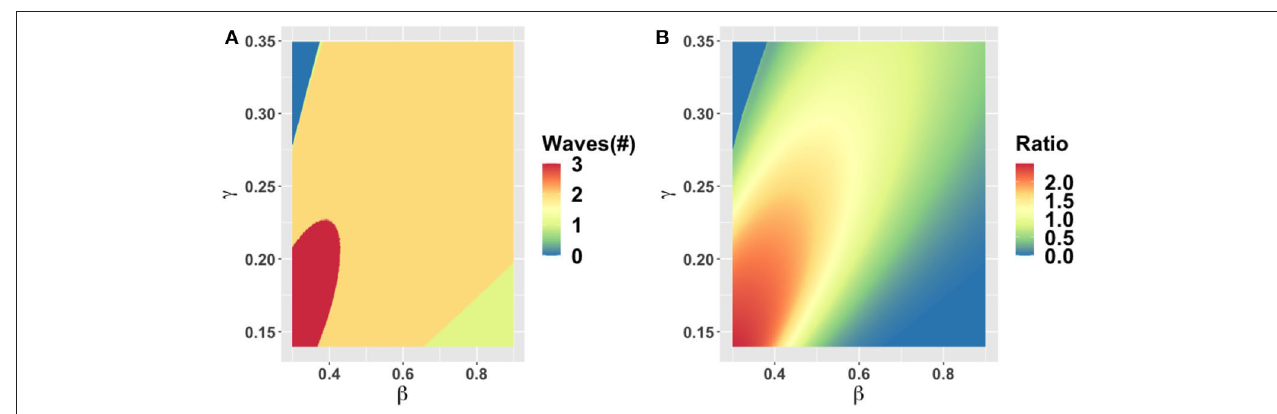
FIGURE 2 | Parameter plane showing model dynamics as they vary with changes in the transmission rate β and the rate γ at which the infectious period ends, for the number of COVID-19 waves (A) and the ratio of peak height of the second wave to the first wave peak (B) . Other parameters are at baseline values ( Table 1 ).